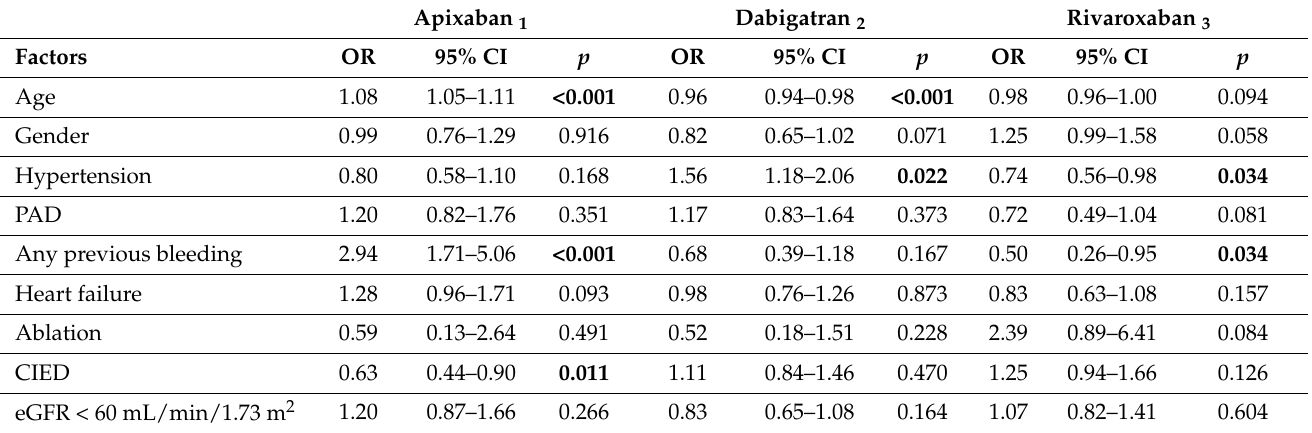
Table 3. Predictors of drug selection in the multivariate logistic regression